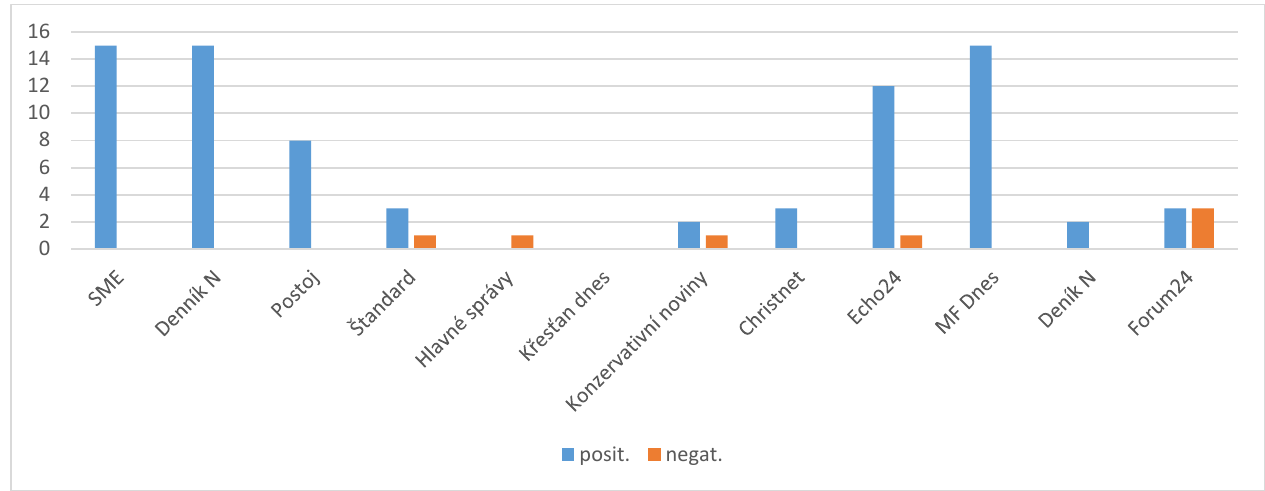
Figure 2. Occurrences of ‘responsibility’ as an argument (A1).